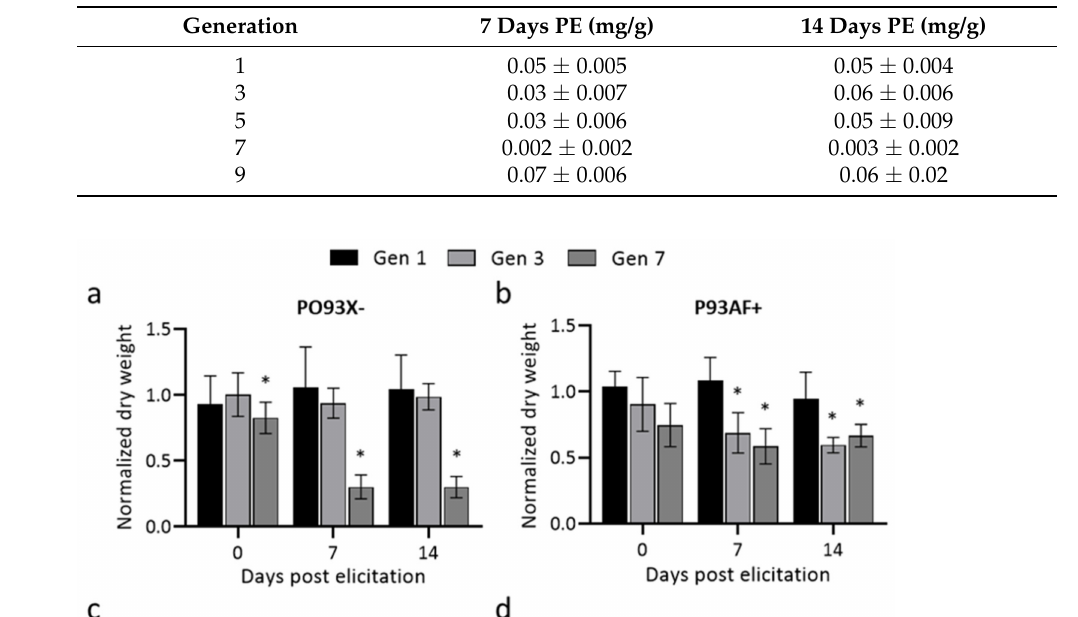
Table 1. Paclitaxel accumulation (mg/g dry weight) in the cell line P93AF+ over nine generations. (PE = post-elicitation) ( n = 3 biological replicates, ± = standard deviation).